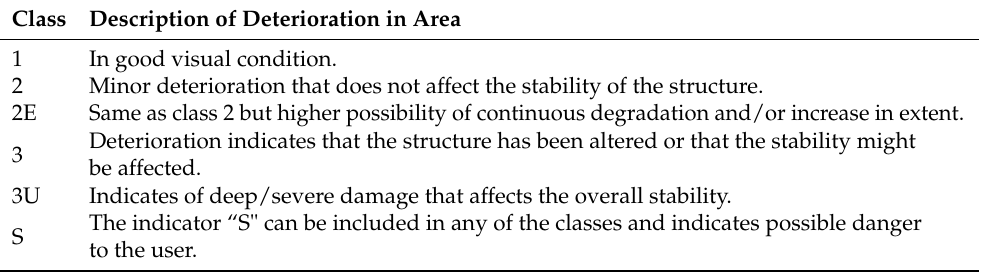
Table 2. Summary of Civil Engineering Rating based on the IQOA system from the French guidelines [23].